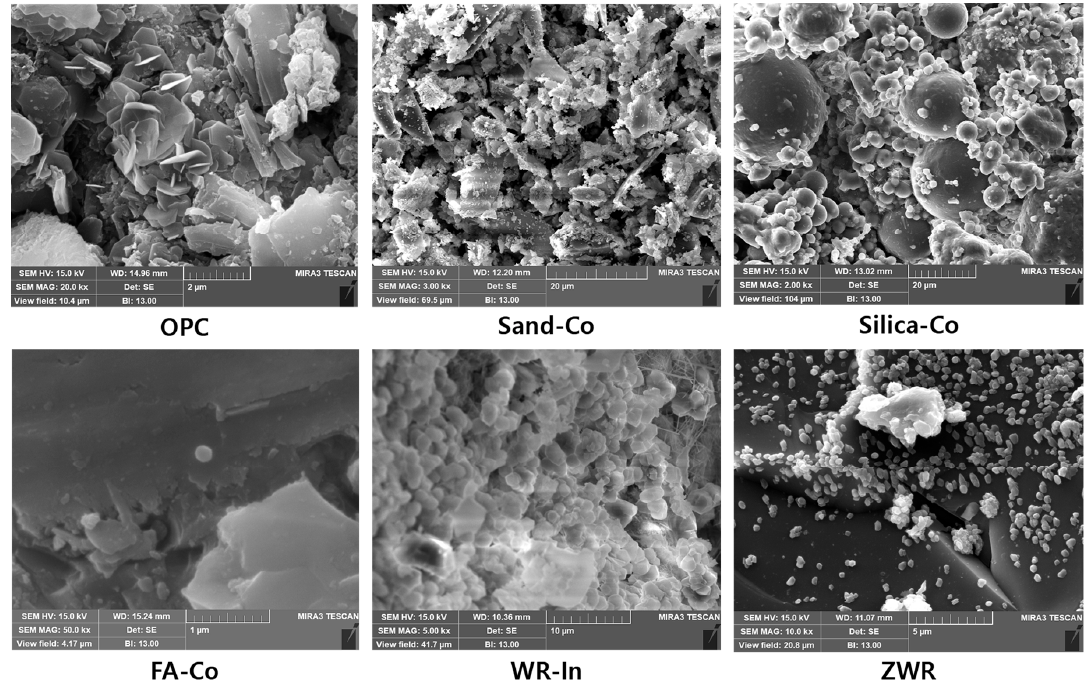
Figure 15. Electron scanning microscope analysis after curing for 7 days.